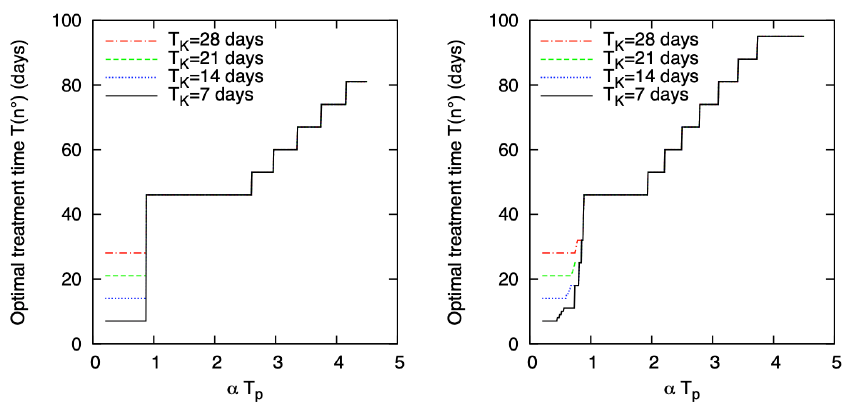
Figure 4. Optimal treatment time T ( n ◦ ) as a function of α T P for ρ = 10 Gy ( left ) and for ρ = 50 Gy ( right ). Daily dose upper bound d M = 7 Gy.